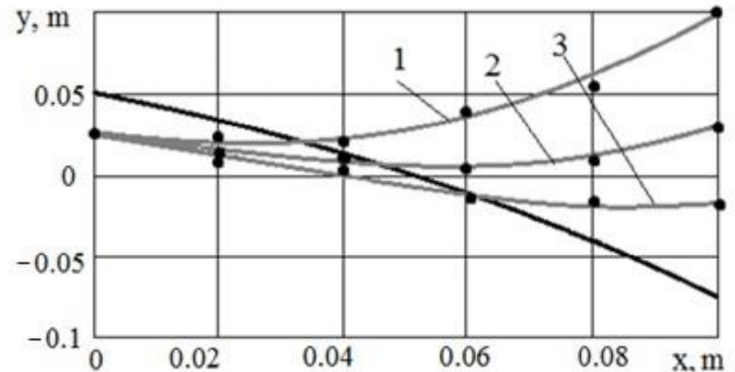
Figure 7. The trajectories of particles of lightweight impurities in the vertical duct: 1— ρ p =400 kg · m 3 ; 2— ρ p = 500 kg · m − 3 ; 3— ρ p = 600 kg · m − 3 ; (H = 0.05 m; y 0 = 0.025 m; i = 7 m · s − 1 ; d p = 0.002 m); —the upper boundary of the grain layer; —trajectories of impurities.